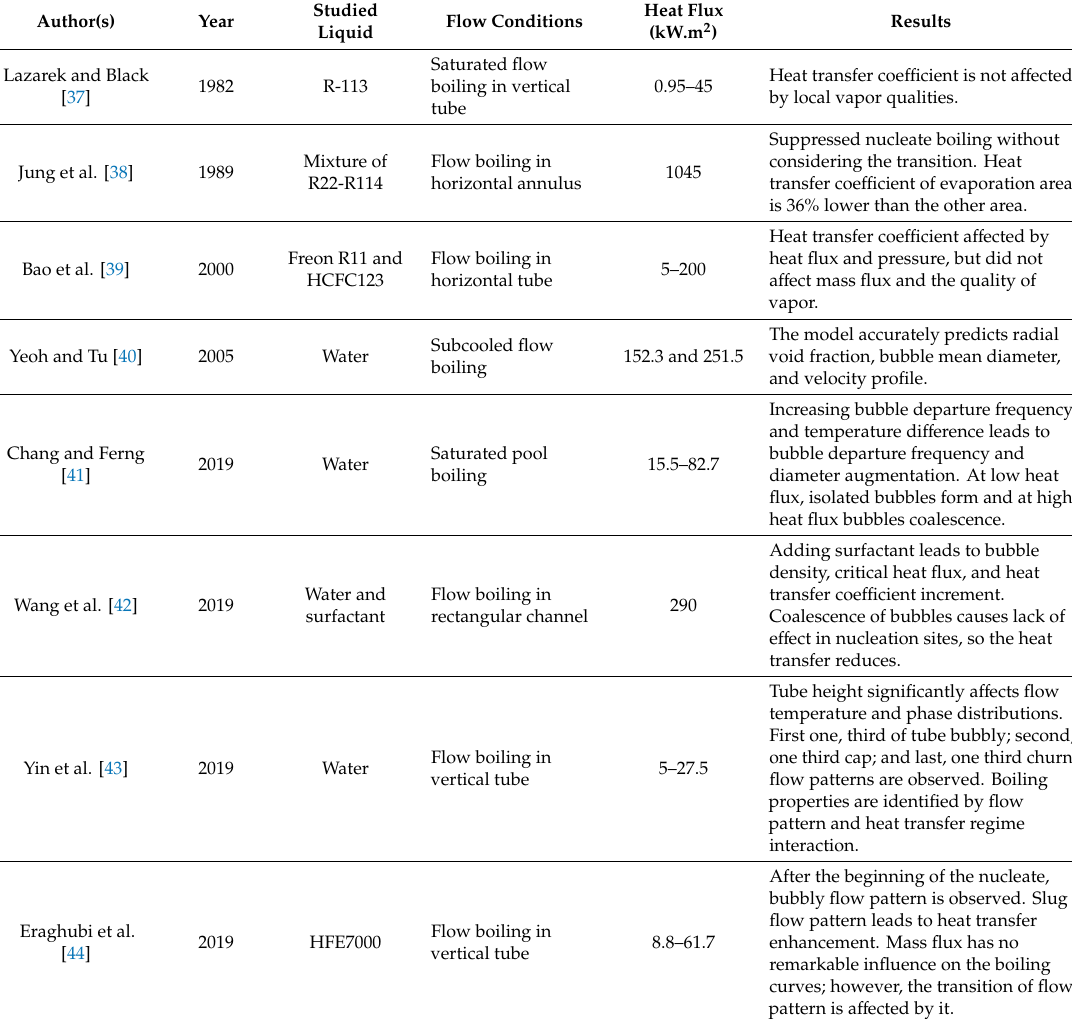
Table 1. Review of papers about bubble formation inside the pipes in flow boiling flow